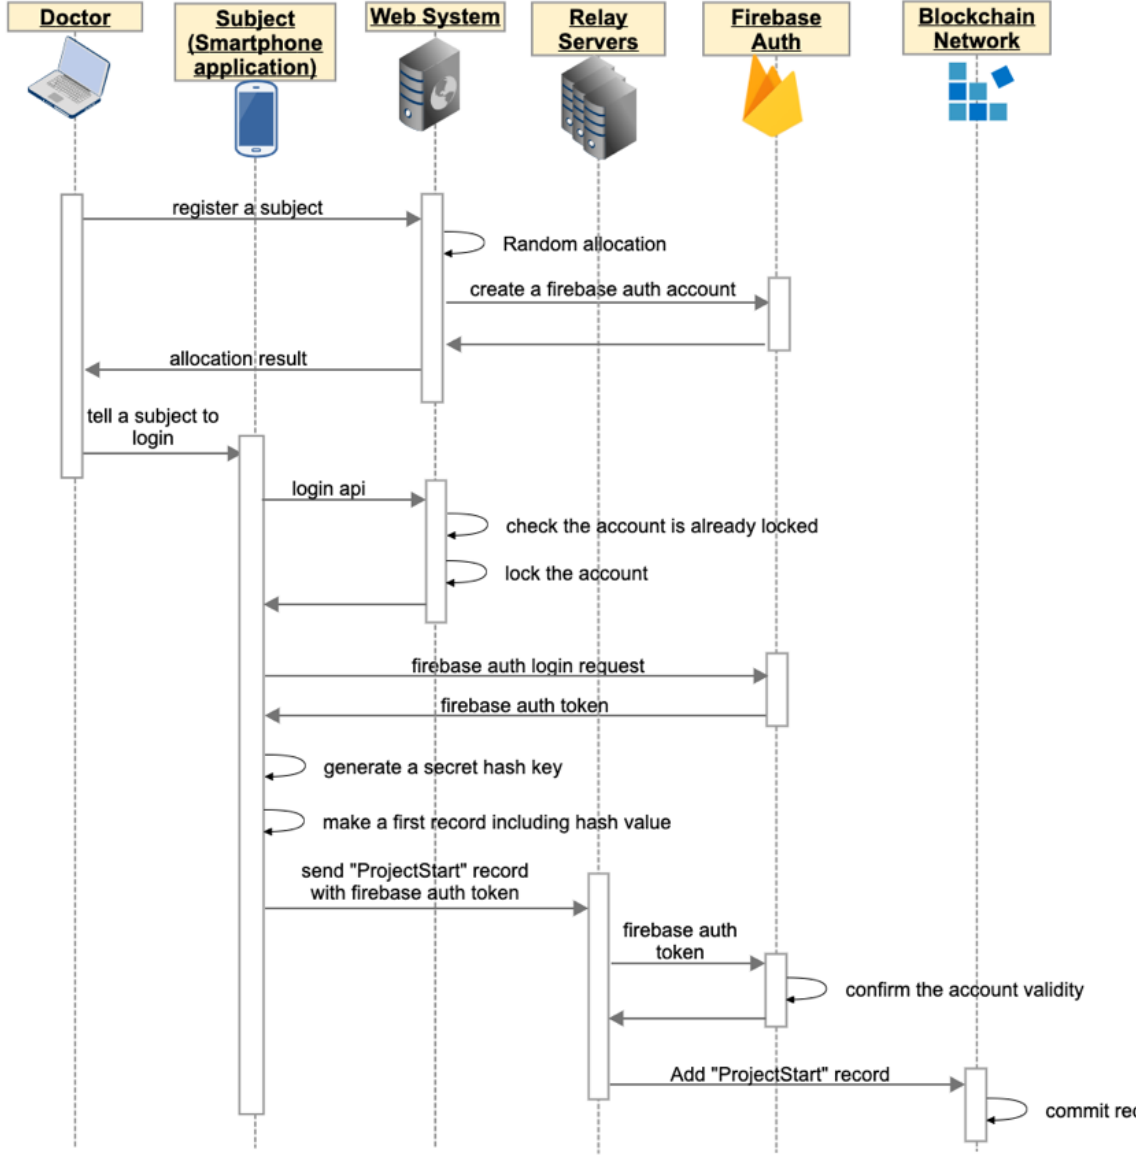
Figure 2. When a participant first visits the hospital, a medical doctor decides if they fit the eligibility criteria. After obtaining informed consent, the doctor registers the patient to the clinical trial using a web-based allocation system. The system automatically creates an account for the participant, and the doctor gives the account to the participant. The participant downloads the app to their smartphone, and they can log in to the app using the account created by the doctor. When the participant first logs in to the app, the account is locked to prevent impersonation, and the secret hash key is then generated. The secret hash key will be preserved in the client app until the participant completes the trial. Using the secret hash key in the client device, the app calculates a hash value. The app sends the first record to the blockchain network via relay servers, and the data is registered in the tamper-resistant blockchain